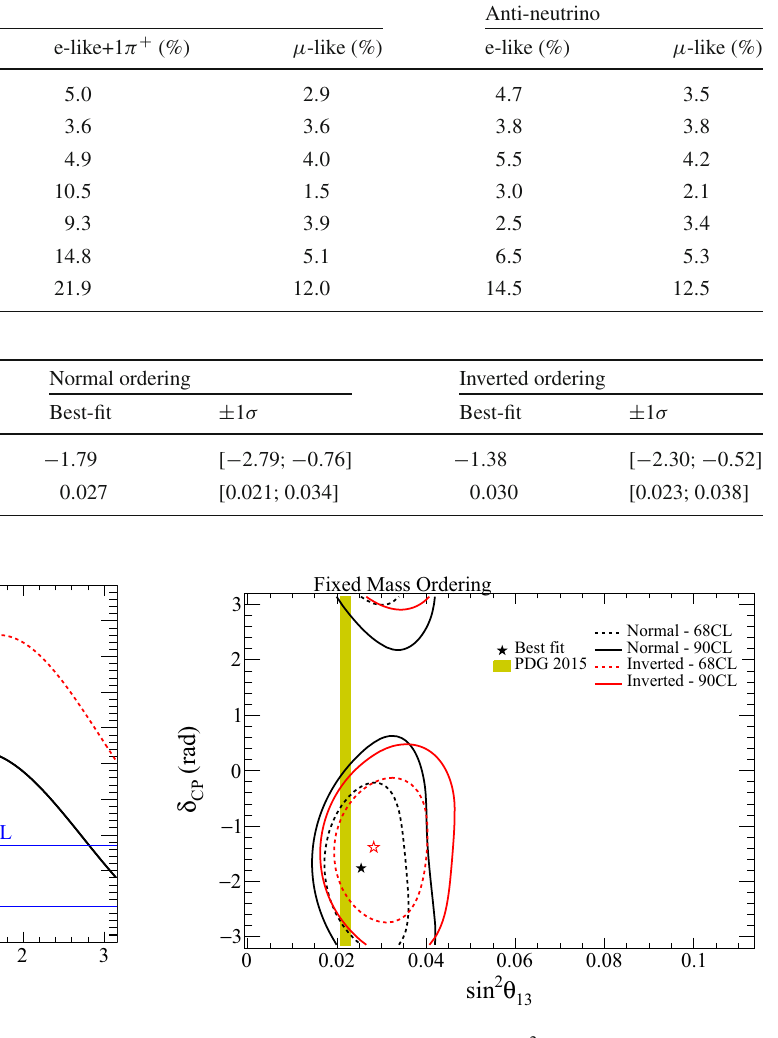
Fig. 72 The 2D − 2 Δ ln L contour of sin 2 θ 13 versus δ CP from [62]. The yellow band corresponds to the reactor value of sin 2 θ 13 from PDG